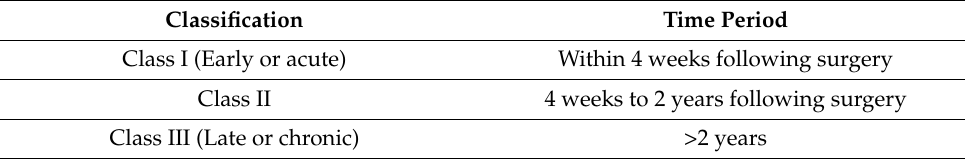
Table 1. Classification of infections in tumor prostheses.